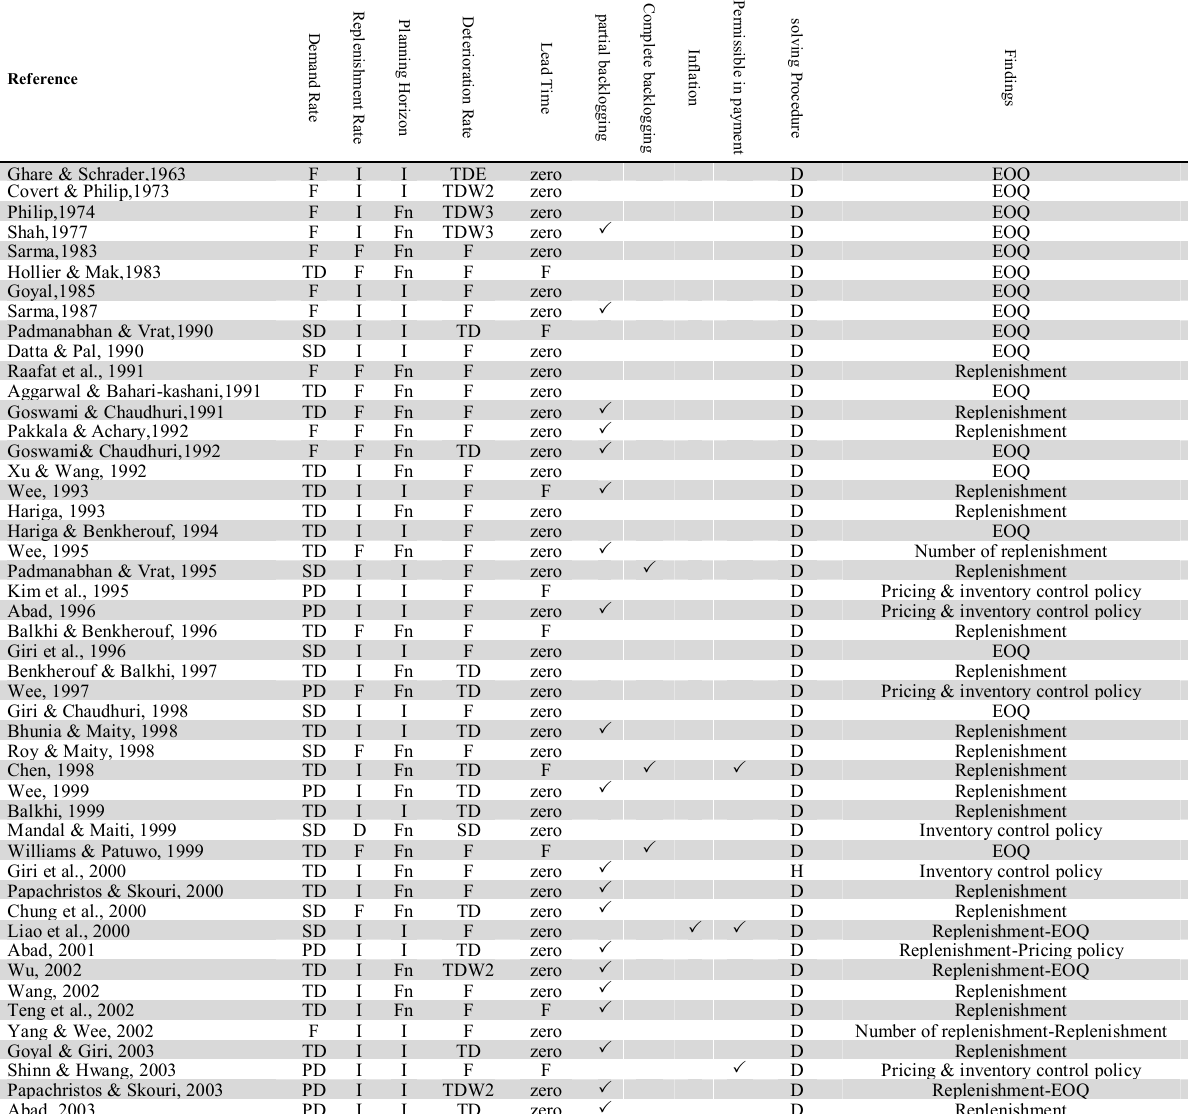
Classification of deteriorating inventory control for one-echelon supply